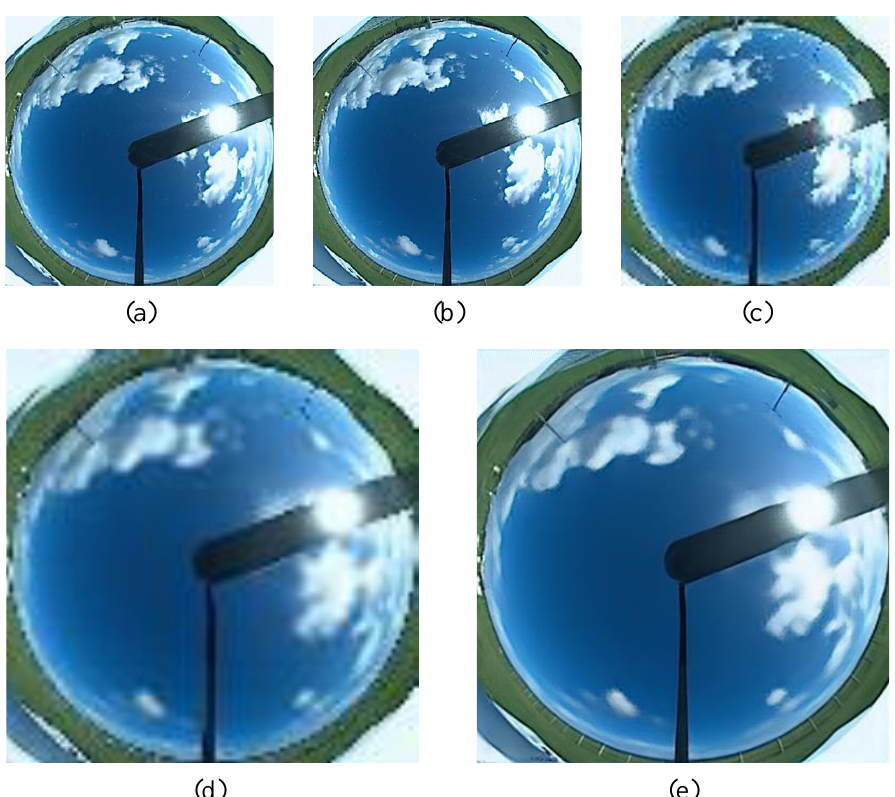
Figure 12. The results of the reconstruction model. ( a ) The real cloud image at time t ; ( b ) the real cloud image at time t + 1; ( c ) the ground truth of the prediction model’s input after downsampling at time t + 1; ( d ) the prediction results at time t + 1 before super-resolution; ( e ) the prediction results at time t + 1 after super-resolution.